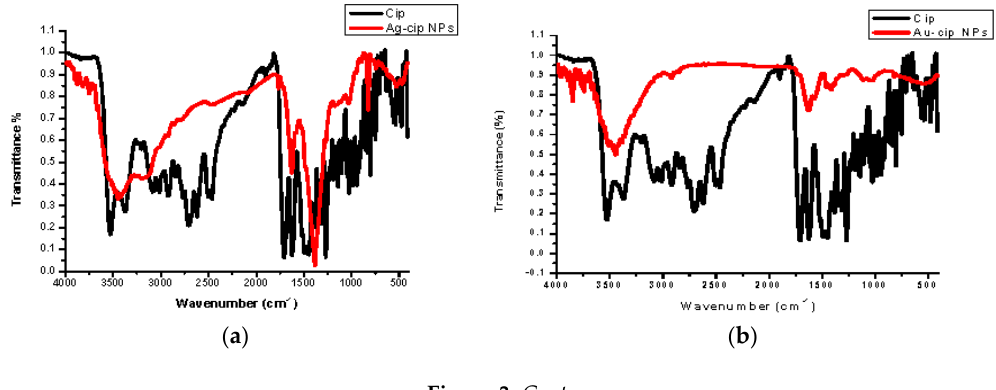
Figure 3 . Cont . Figure 3. Cont